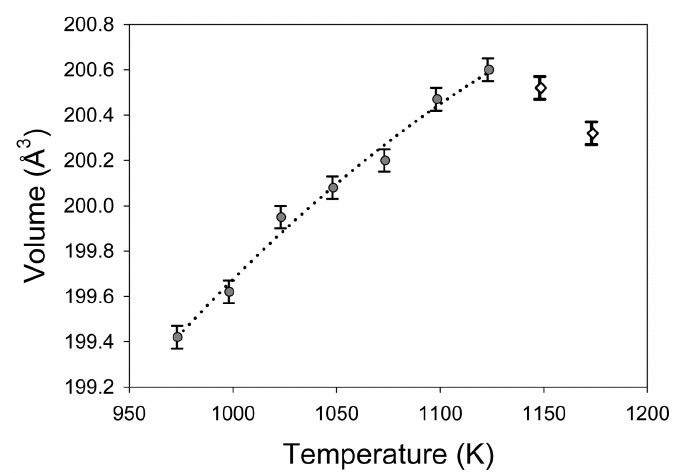
Figure 8. Measured unit cell volumes for cubic α-LaOF as a function of temperature from 973 K to 1123 K. Gray-filled circles represent data used to fit the thermal equation of state in this temperature range. White diamonds represent temperature points 1148 K and 1173 K, which are above the temperature that coincides with a contraction in unit cell volume and an exotherm on the DSC curve. The dotted black line is the fit for the Fei thermal equation of state [40].